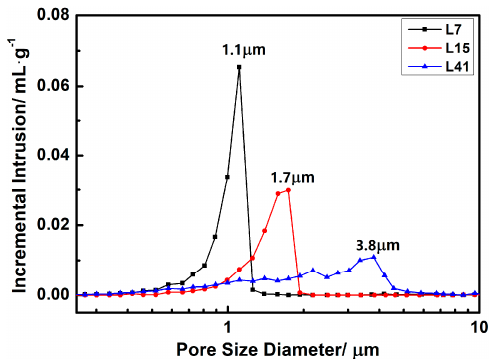
Figure 2. Pore size distribution of porous L-SiC ceramics with different particle sizes of the initial coarse SiC powder.